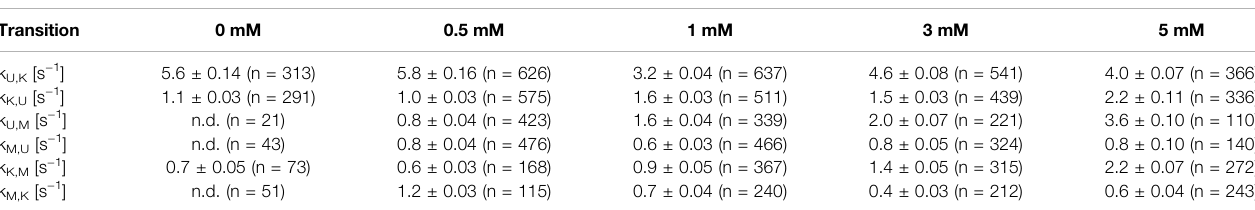
TABLE 1 | Transition rates derived from dwell time fi ts at various Mg 2+ concentrations.